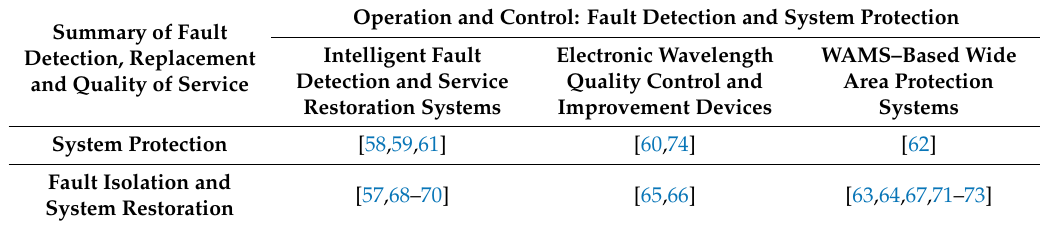
Table 3. Summary of Fault Detection, Replacement and Quality of